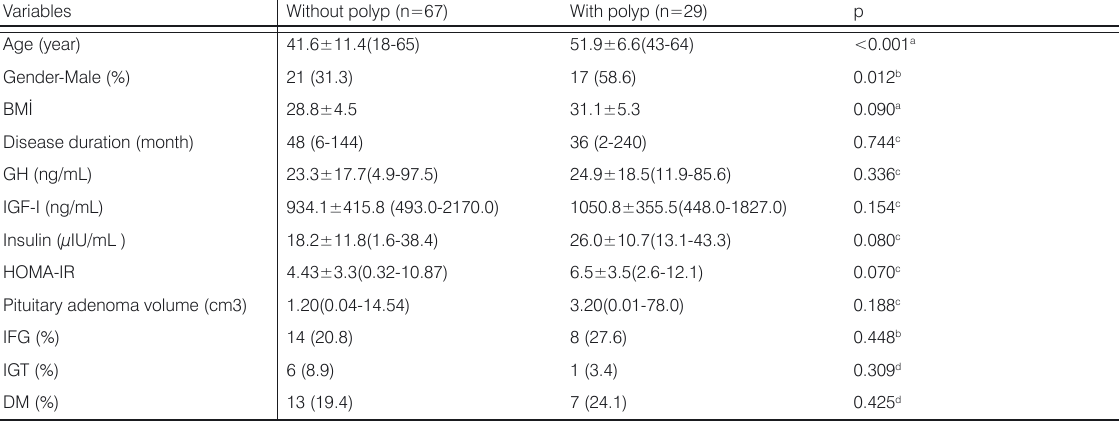
a Student’s t test. b Pearson Chi-square test. c Mann Whitney U test. d Fisher’s Exact Probability